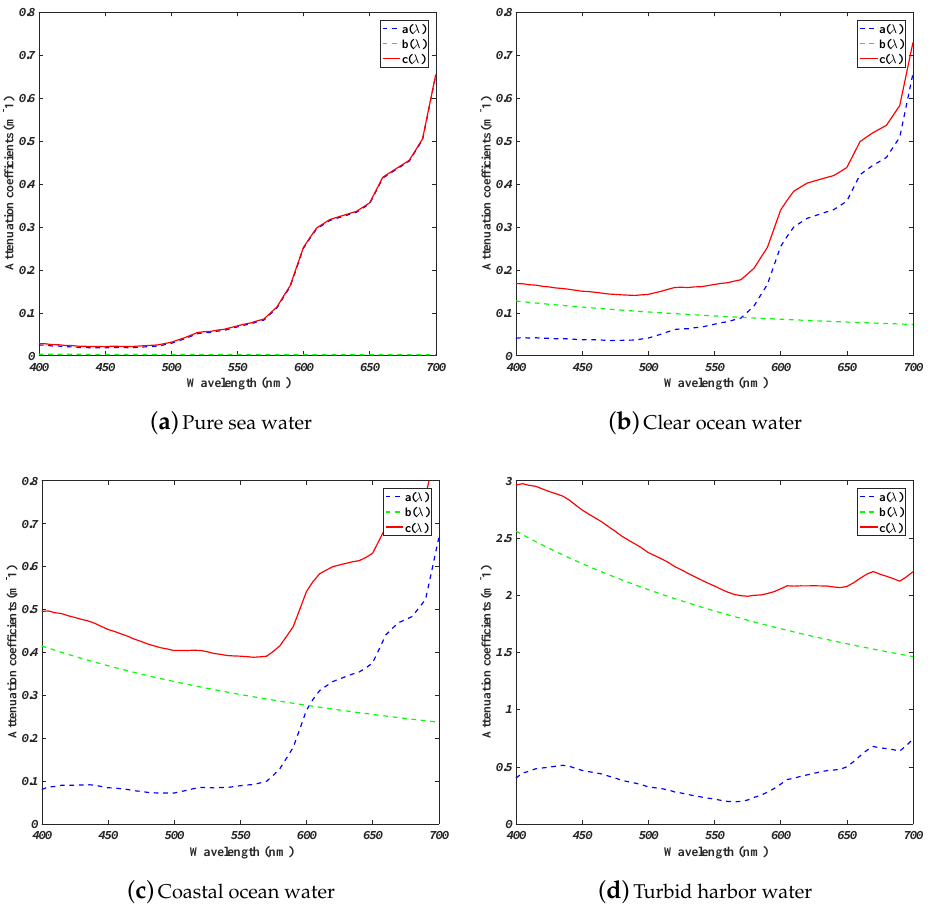
Figure 1. (Color online.) The attenuation coefficients of the four different types of seawater as functions of wavelength of the signal light. The blue dashed line, the green dashed line, and the red solid line represent the change curves of the absorption coefficient a ( λ ) , the scattering coefficient b ( λ ) , and the total attenuation coefficient c ( λ ) , respectively.